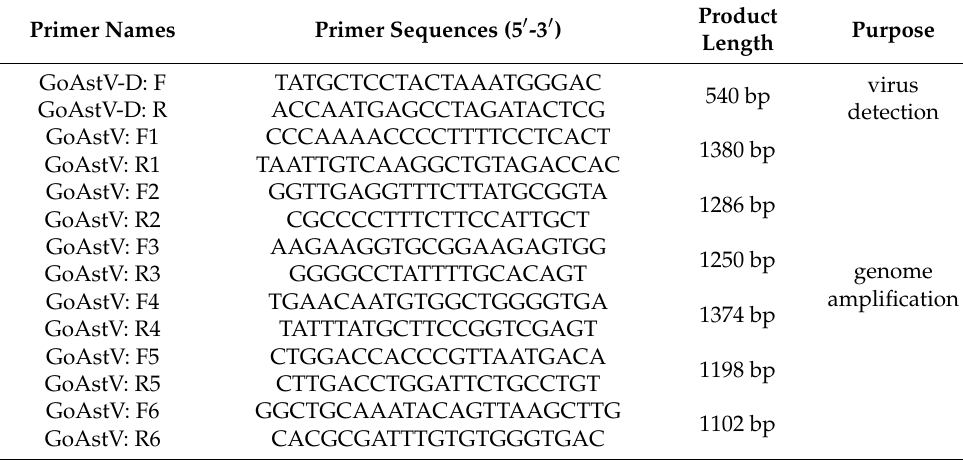
Table 1. Primers used for RT–PCR detection and genome amplification of the GoAstV in this study designed by AAstV/Goose/CHN/2017/SD01